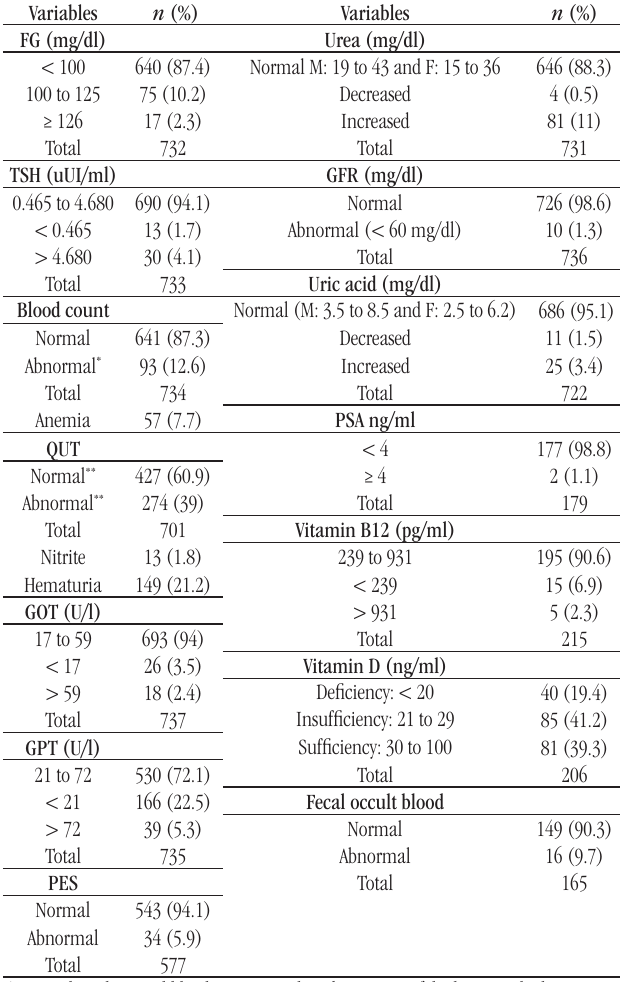
table 1 − Prevalence of results in laboratory tests